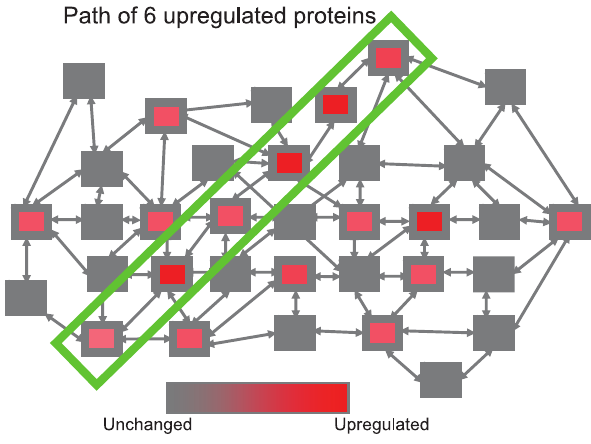
Figure 1. Enriched molecular path detection concept. Illustrative example of path detection in a complex network of interacting entities. An enriched path of 6 entities is highlighted.